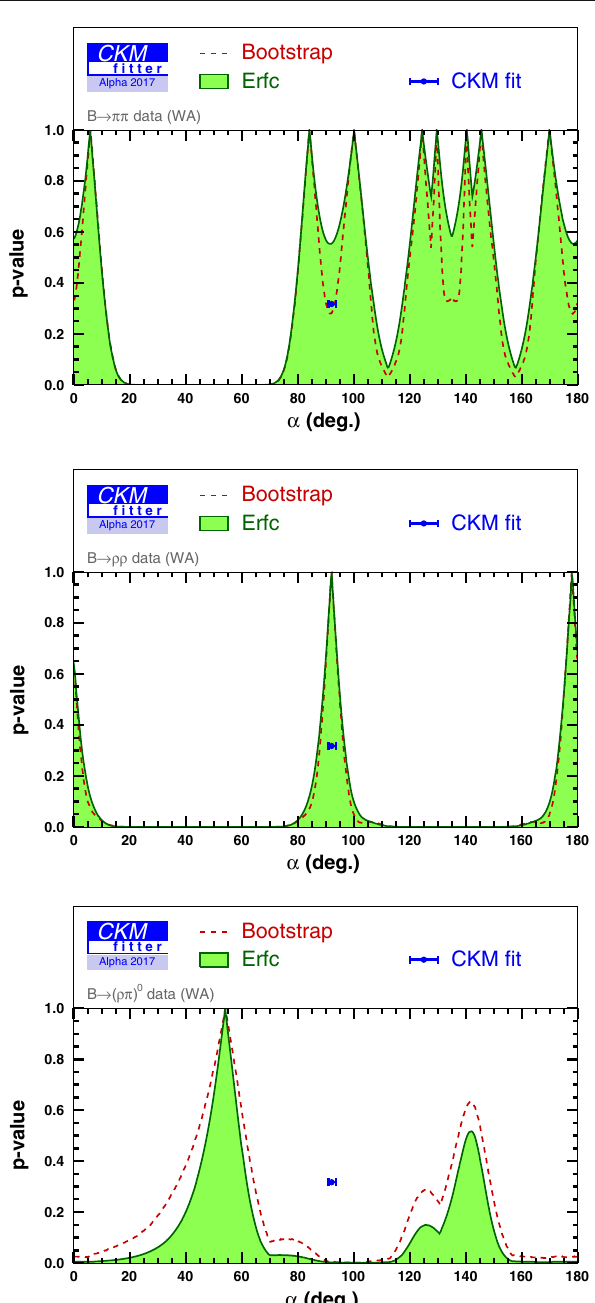
Fig. 17 p value for α comparing the Wilks-based approach (denoted Erfc) and the full frequentist approach based on the bootstrap method for B → ππ ( top ), B → ρρ ( middle ), B → ρπ ( bottom )